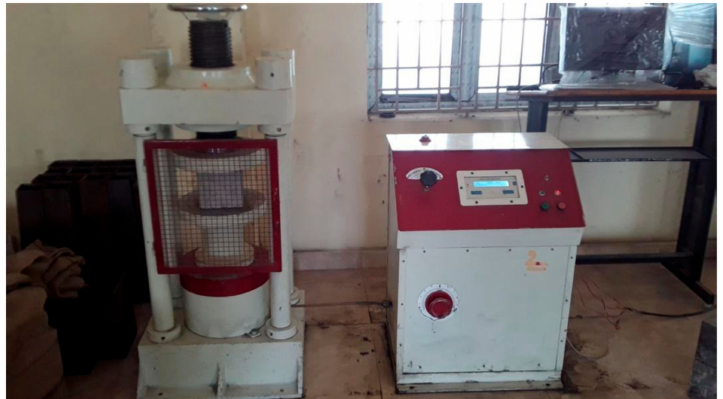
Figure 4. Compression Testing